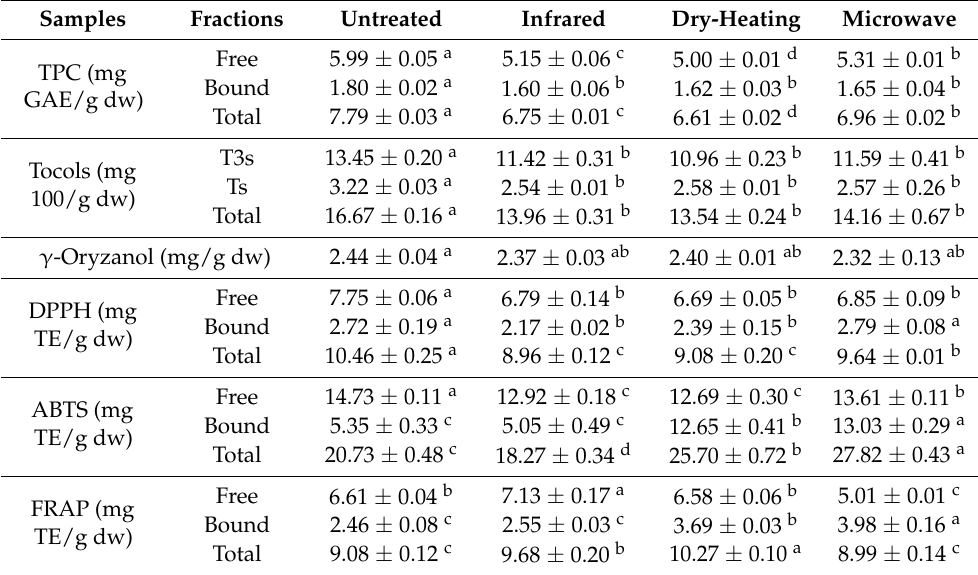
Table 4. Bioactive components of RB samples before and after heat